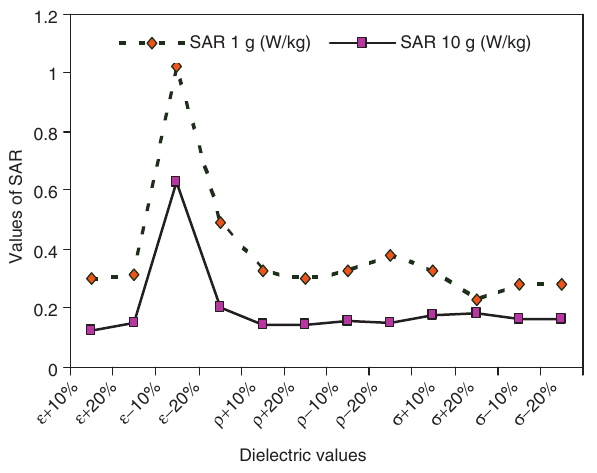
Figure 6 Deviation of the peak of unaveraged SAR in different dielectric properties of FR4 substrate at 2450 MHz.